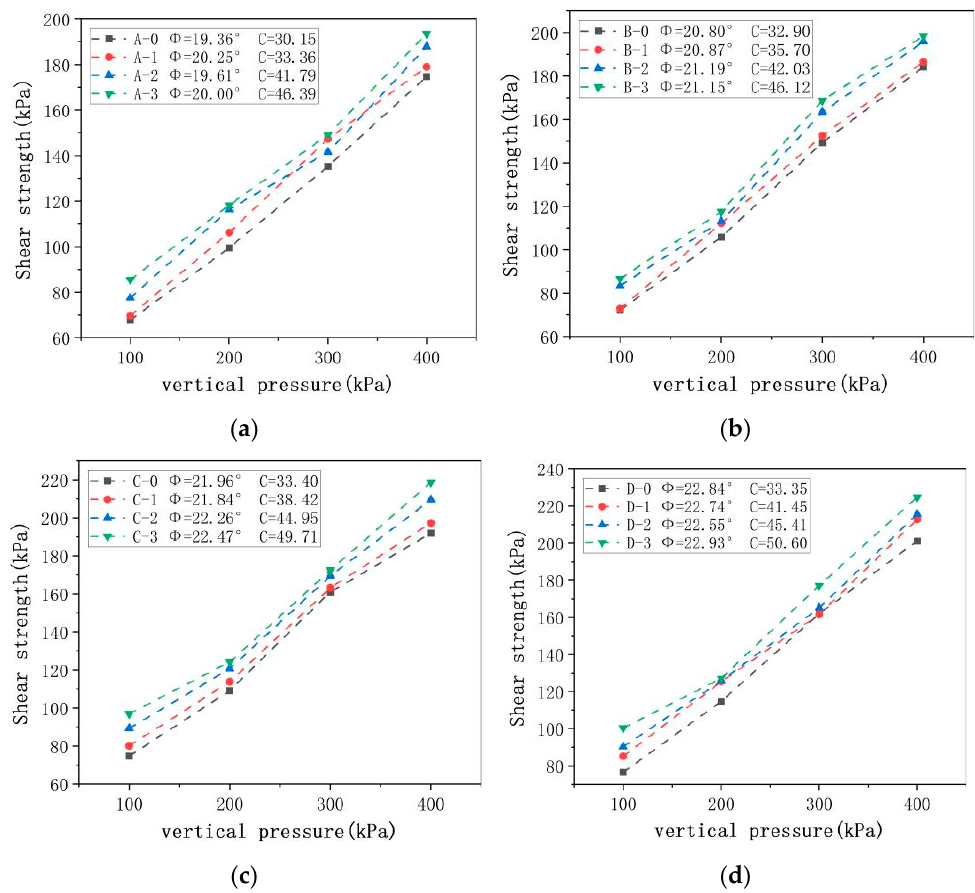
Figure 3. Fitting curve of shear strength of each group of soil samples: ( a ) Group A; ( b ) Group B; ( c ) Group C; ( d ) Group D.